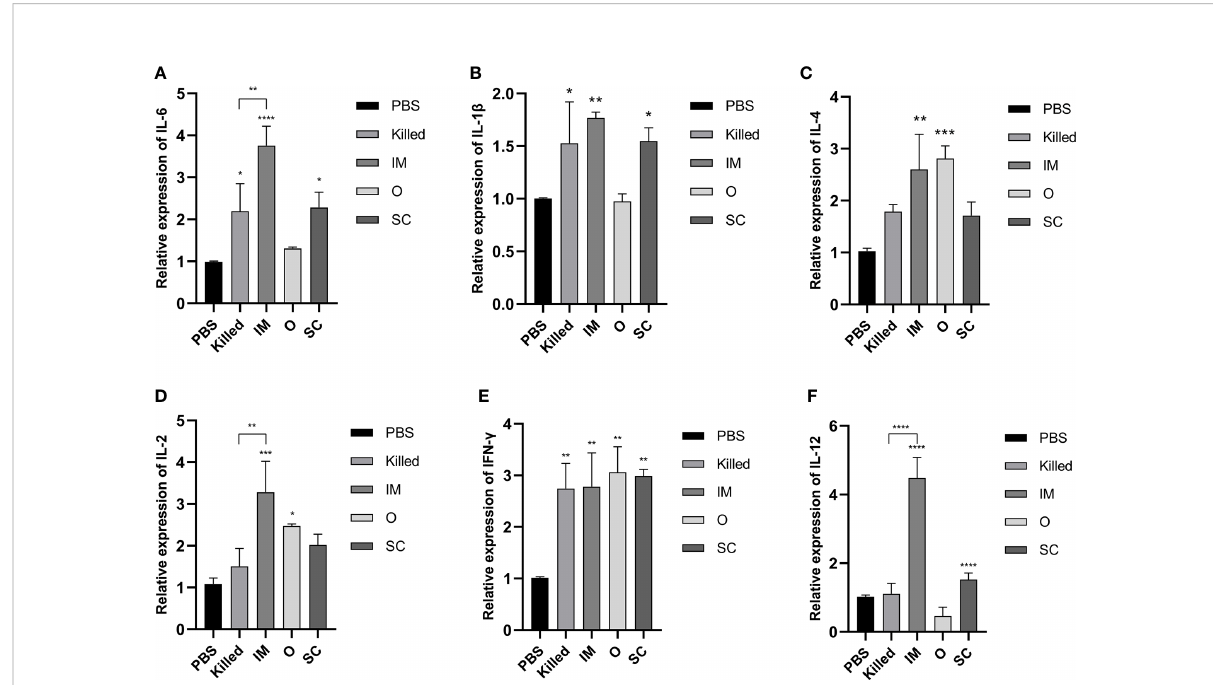
FIGURE 4 Cytokine expression was assessed by RT-qPCR normalized to GAPDH at day 28 post-immunization. All groups were compared to the PBS group. The expression of IL-6 (A) and IL-1 b (B) in the Killed group, IM group, and SC group were signi fi cantly elevated. The IL-4 expression levels (C) in the IM and O groups were signi fi cantly higher than the other groups. The IM group had the highest IL-2 expression level (D) among all groups. IFN- g titers (E) were signi fi cantly higher in all immunization groups. The IM group had the highest IL-12 titer (F) among the groups. Signi fi cance was analyzed using 1-way ANOVA and Tukey ’ s multiple comparisons test. *p<0.05, **p<0.01, ***p<0.001,